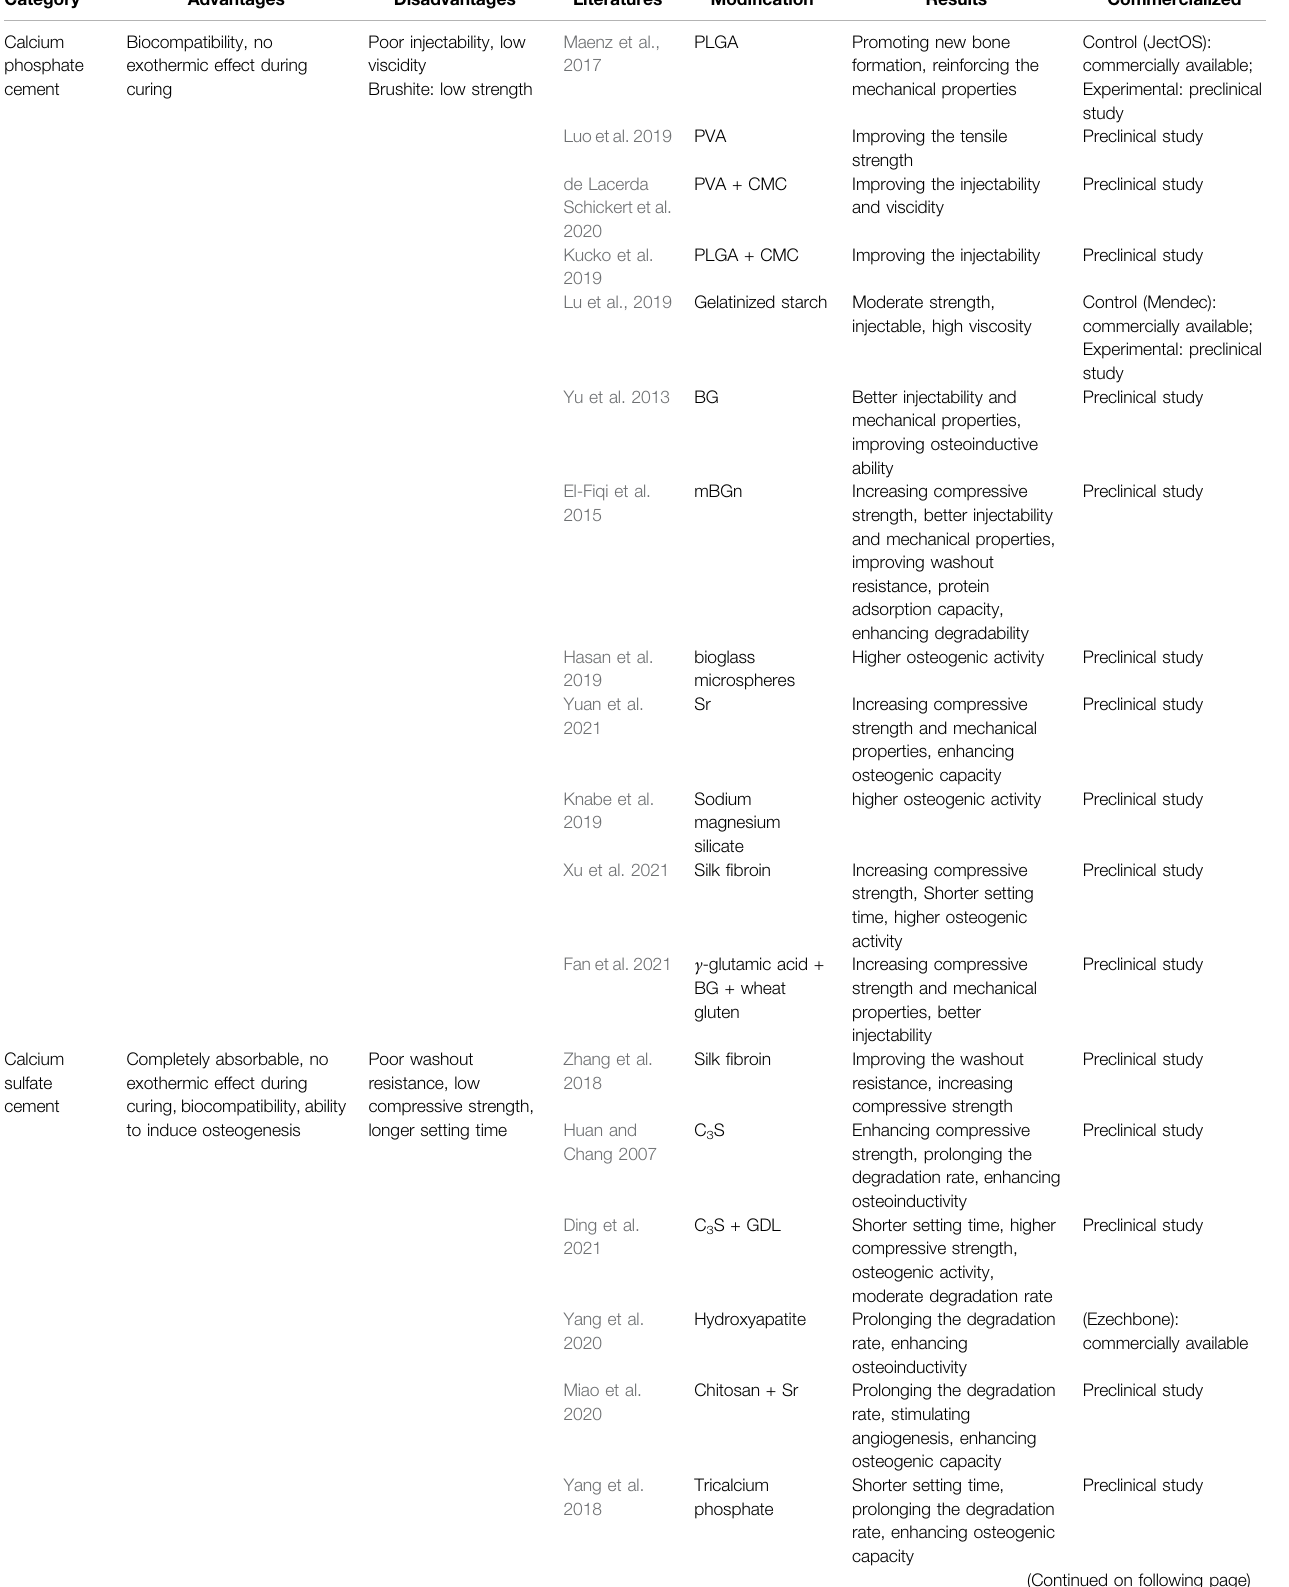
TABLE 2 | Characteristics of inorganic bone cement and its modi fi